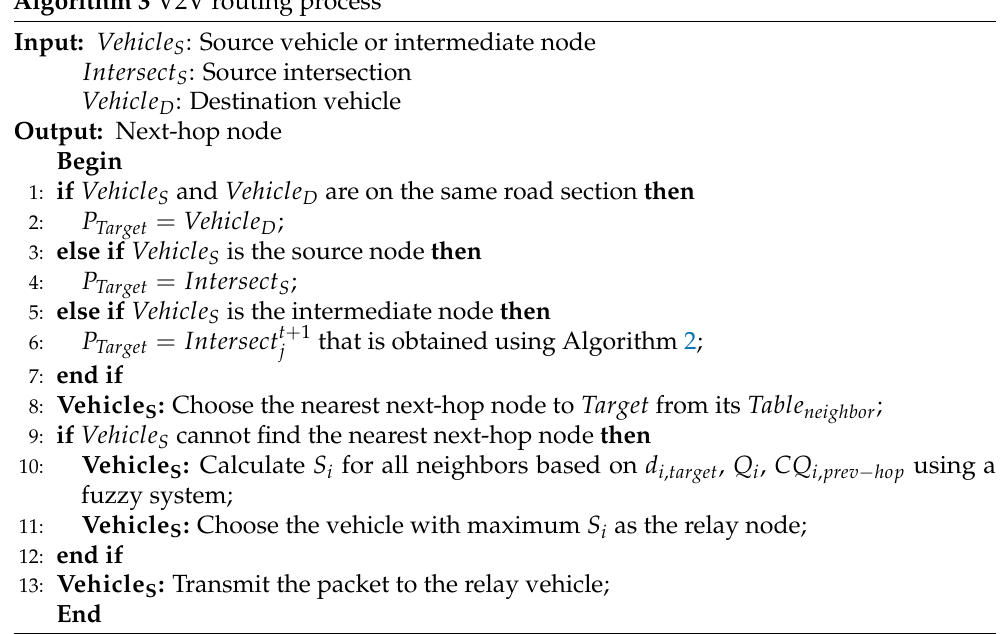
Algorithm 3 V2V routing